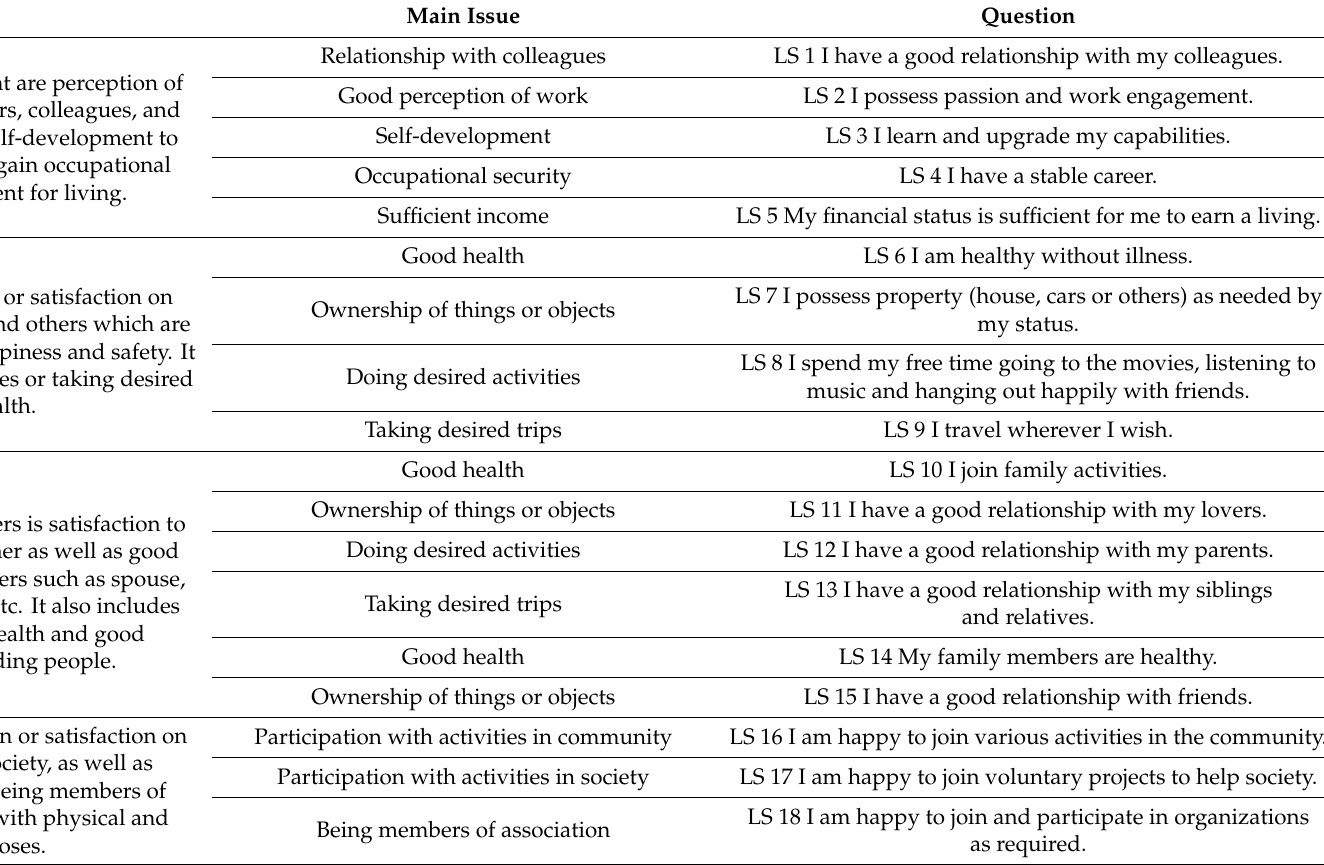
Table 1. LS item